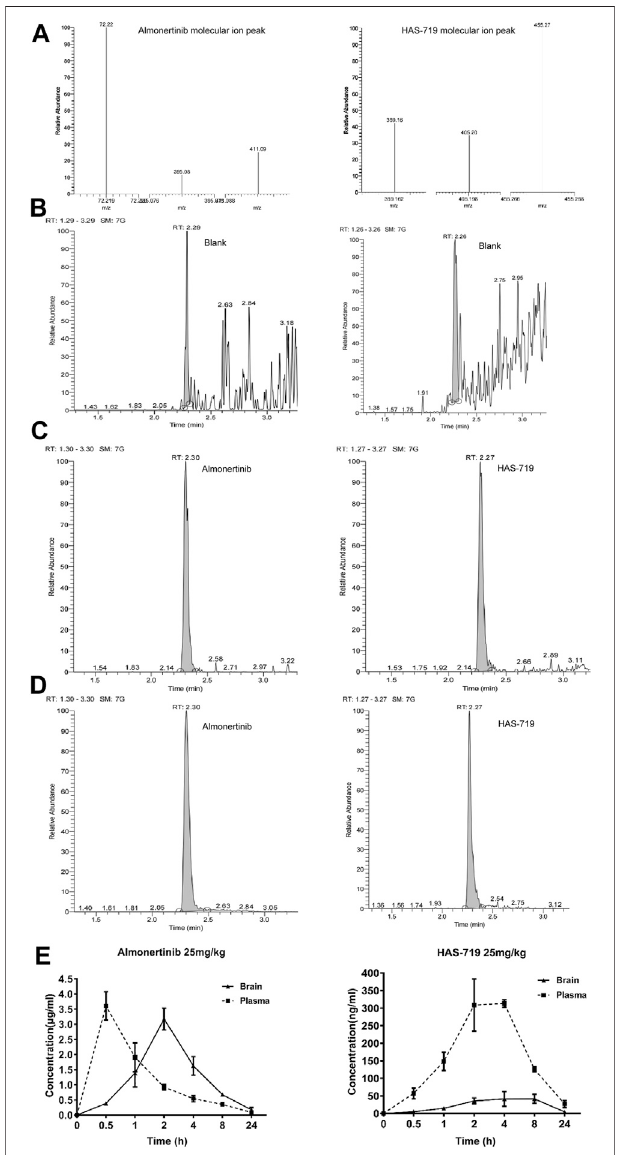
FIGURE 4 | Almonertinib and its metabolite HAS-719 in the brain tissue and plasma of mice with brain metastases were determined by liquid chromatography-mass spectrometry (LC-MS). (A) The second-order mass spectra of almonertinib and HAS-7A9; the typical LC-MS chromatograms of almonertinib (left) and HAS-7199 (right) . (B) Blank plasma; (C) blankplasmamixedwithstandardalmonertinibandHAS-719; (D) almonertinib 25 mg/kg was orally administered to mice. (E) Concentration- time pro fi les of almonertinib and HAS-719 after the oral administration of almonertinib in mice with brain metastases ( n (cid:2)